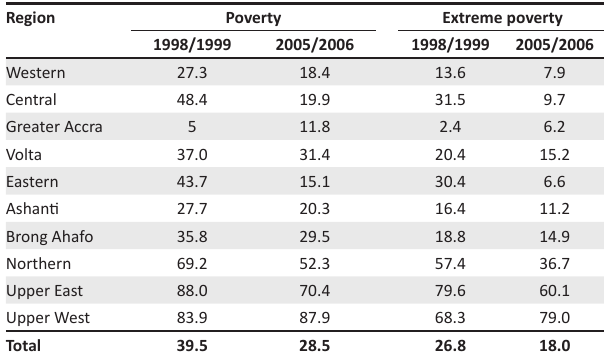
TABLE 3: Poverty incidence by Administrative